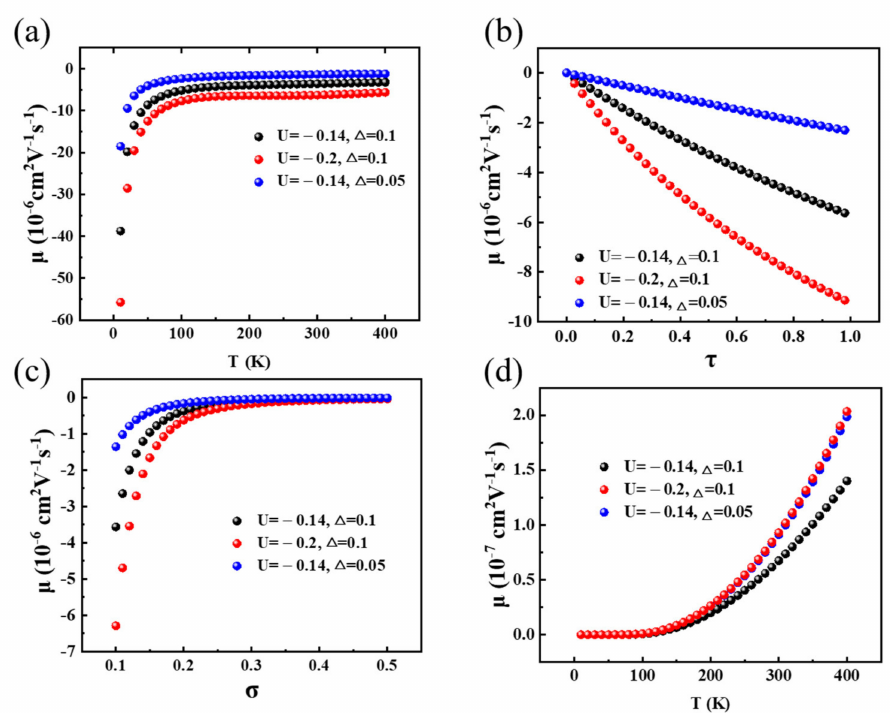
Figure 4. ( a ) The negative coulomb drag mobility varies with temperature. ( b ) The negative coulomb drag mobility varies with the ratio of the lattice relaxation time to the total time. ( c ) The negative coulomb drag mobility varies with the ratio of the disorder. ( d ) The positive coulomb drag mobility varies with temperature. In this calculation, v p = v p 2 is assumed ( τ = 0 ). U and ∆ mean